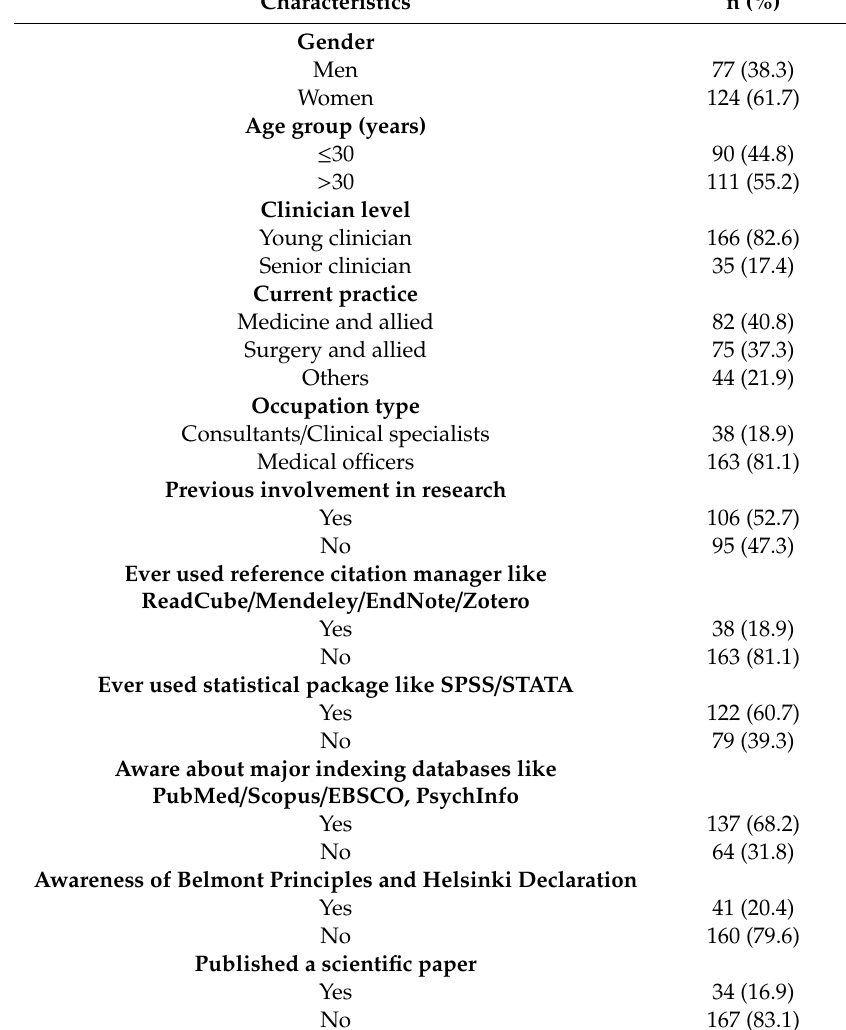
Table 1. Clinicians’ Socio-Demographic Characteristics and Researching Habits ( n =